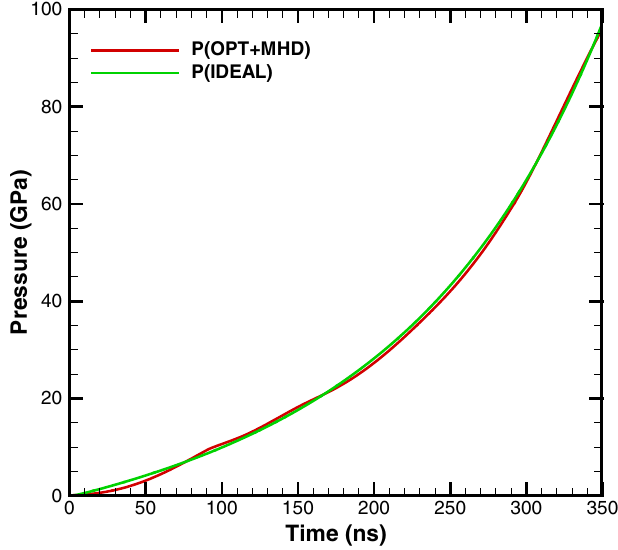
FIG. 18. Pressure profile obtained by using the voltage from the optimization procedure in the MHD code compared to the ideal pressure